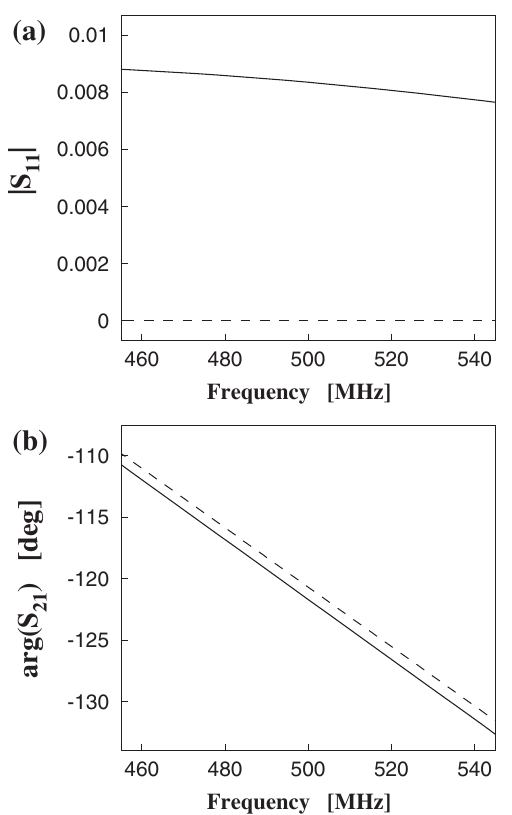
j and (b) arg ð S Þ of the S parameters for the FIG. 11. (a) j S 11 21 grooved coaxial line with a pitch of 2.0 mm and a depth of 1.4 mm (solid lines). The dashed lines indicate the S parameters for the ungrooved coaxial line.